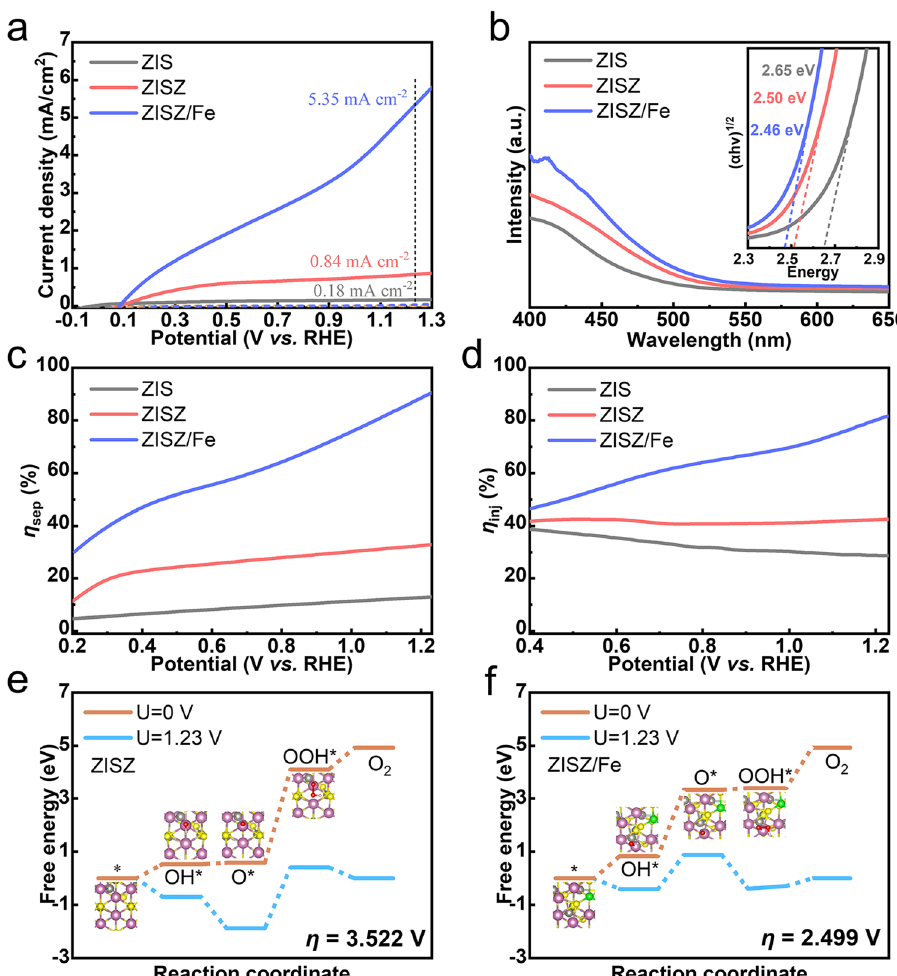
Fig. 3 PEC performance, optical, and electrochemical characterizations. a Linear sweep voltammogram curves. b UV-visible absorption spectra (the inset is the corresponding Tauc-plots). c The η sep and d the η inj of ZIS, ZISZ, and ZISZ/Fe. Free energies of OER reaction steps for e ZISZ and f ZISZ/Fe systems, the entire structure of the OER four-step reaction are shown in Supplementary Fig.